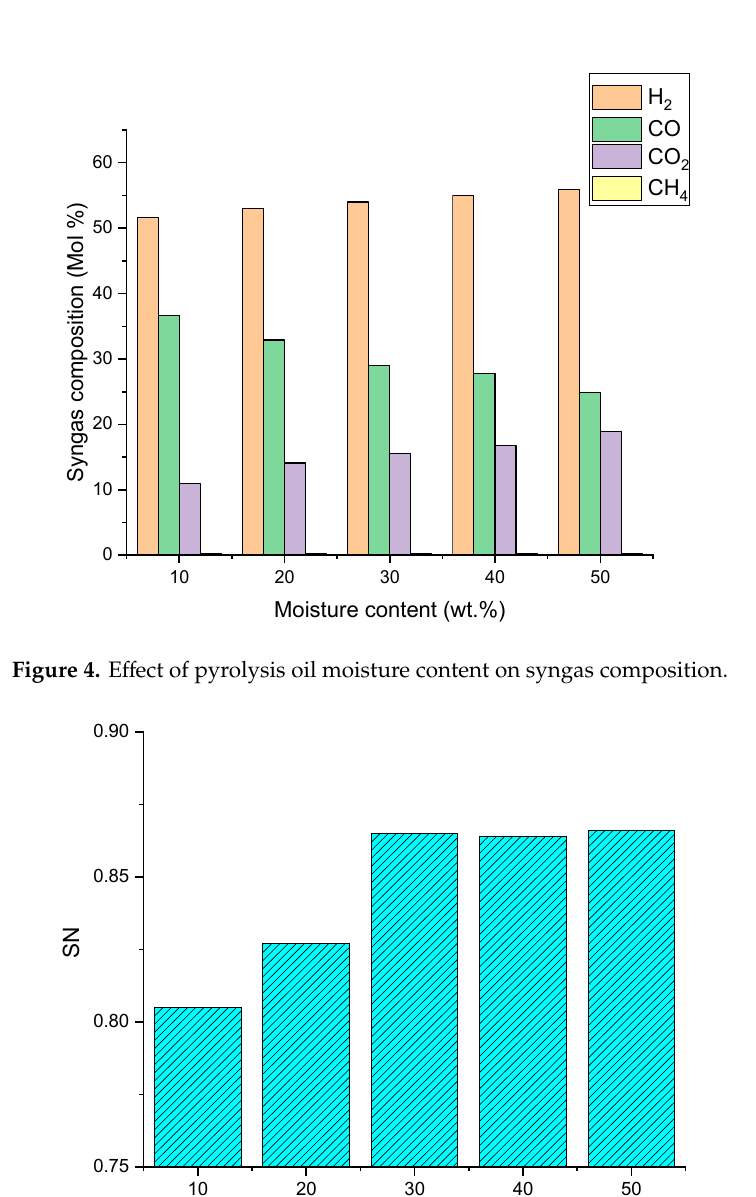
10 of 18 Figure 3. Effect of gasifier temperature on stoichiometric number (SN) 3.2.2. Effect of Pyrolysis Oil Moisture Content Figures 4 and 5 present the effects of pyrolysis oil moisture content on syngas composition and SN between 10 wt.% and 50 wt.%. According to water gas shift reaction (R-7) and water gas reaction (R-6), moisture content in pyrolysis oil increases the mole fraction of H 2 and CO 2 , while the amount of CO decreased. As a result, the SN value constantly increased from 0.805 to 0.865 with the pyrolysis oil moisture content from 10 wt.% to 30 wt.%. When the moisture content is more than 30 wt.%, the H 2 and CO 2 concentrations continually increase while the CO decreases and the SN value is maintained at 0.865. Therefore, the moisture content in pyrolysis oil seems to be the most beneficial